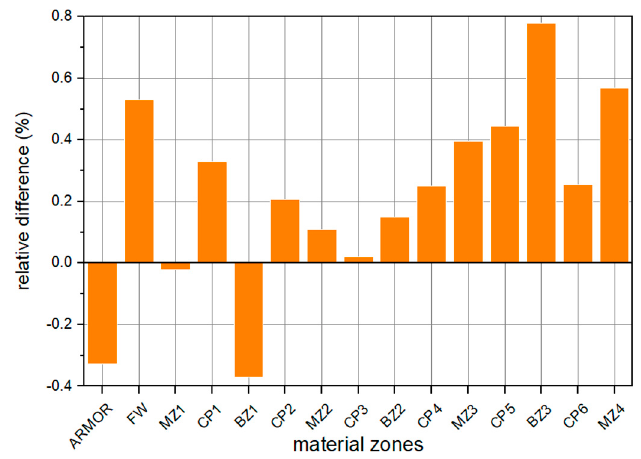
Figure 16. The relative differences of the power density between the one-way and two-way N/TH coupling calculations.